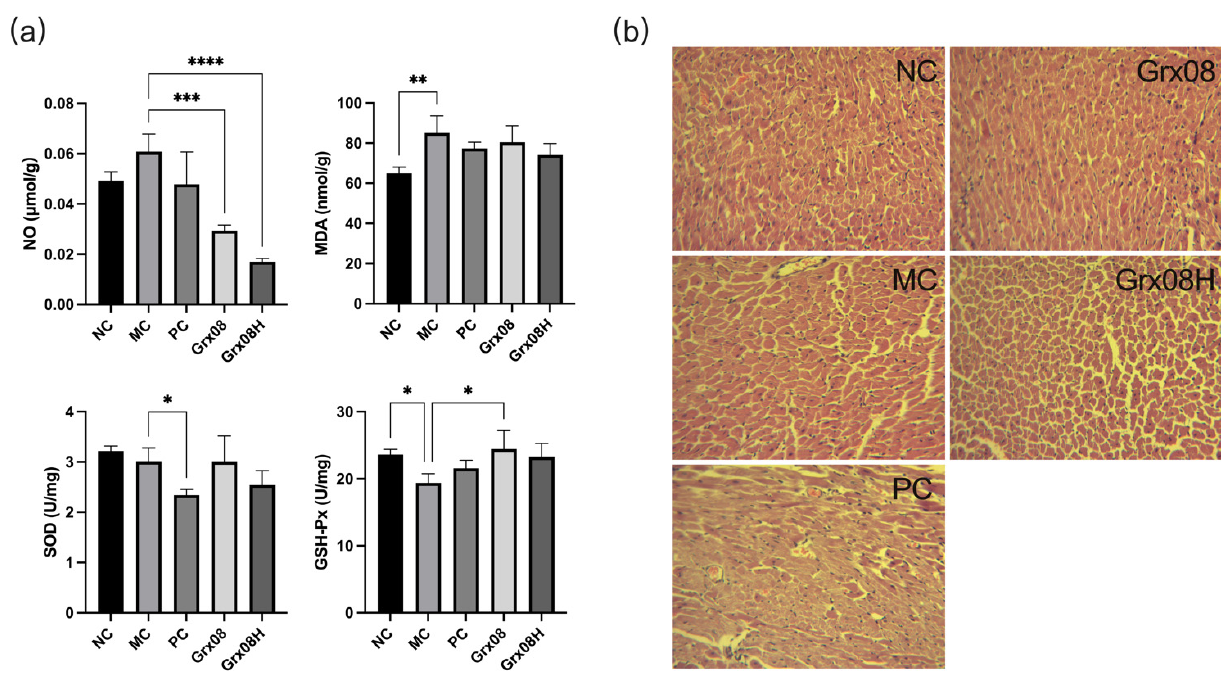
Figure 3. Effect of probiotics on anti-oxidative stress of rat heart ( n = 5). ( a ) Oxidative damage and antioxidant enzyme activity in rat heart, ( b ) Case study of rat heart ( × 200). * indicates a significant difference between groups ( p < 0.05), ** indicates a significant difference between groups (p < 0.01), *** indicates a significant difference between groups ( p < 0.001), **** indicates a significant difference between groups ( p <